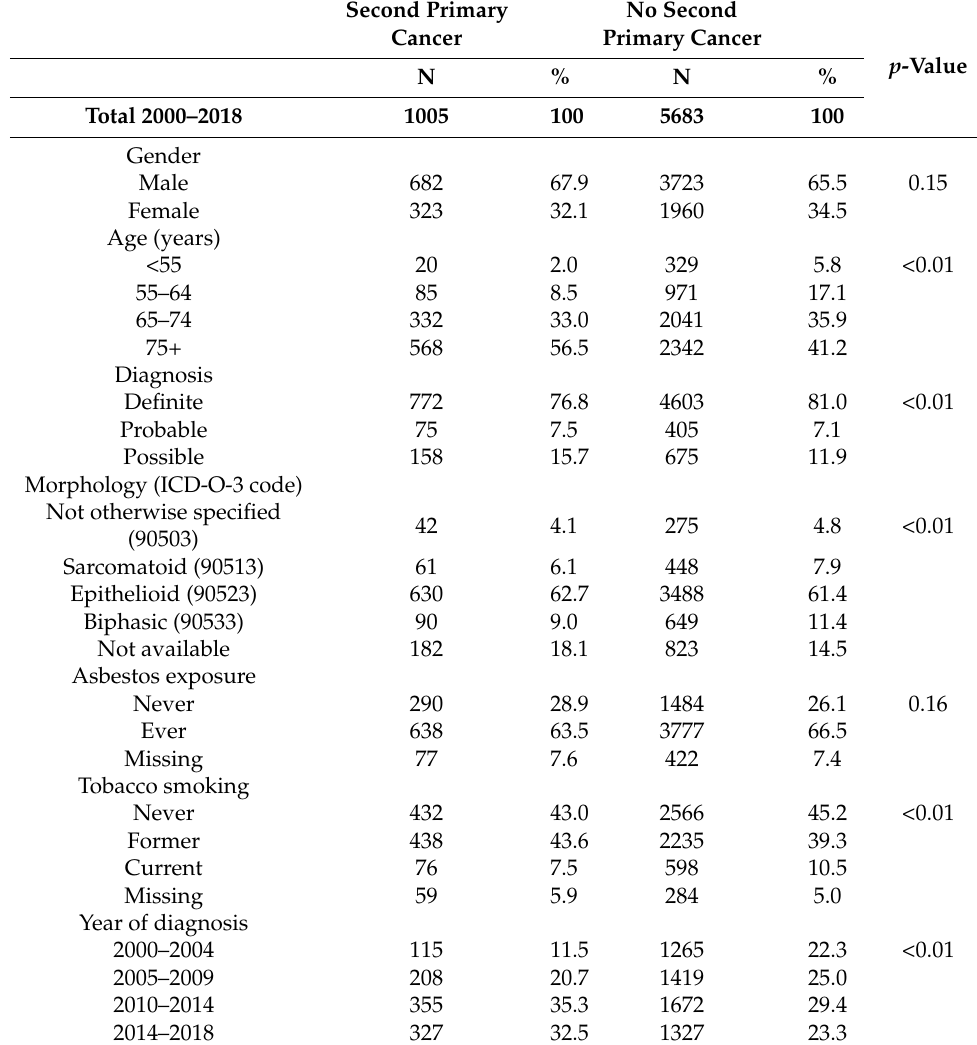
Abbreviations: ICD-O-3, International Classification of Diseases for Oncology, 3rd